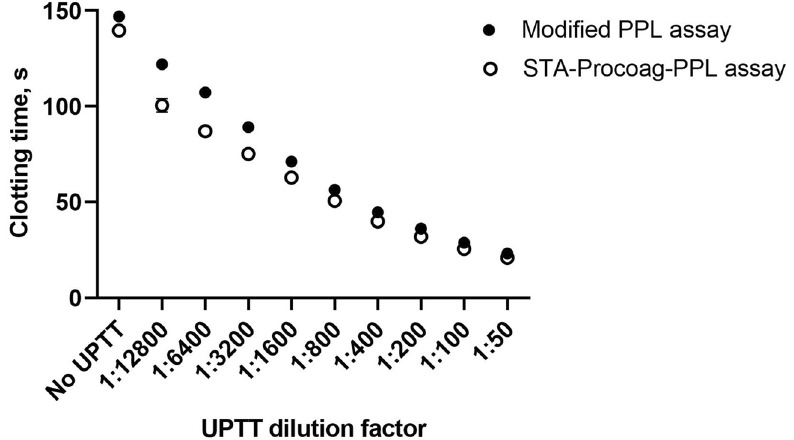
Figure 2. Comparison of the clotting times obtained by the STA-Procoag-PPL and the modified PPL assays using a standardized phospholipid reagent (UPTT reagent). Serial dilutions of UPTT (from 1/50 to 1/12,800), was added to PPL depleted plasma and tested on the modified PPL assay (closed circles) and the STA- Procoag- PPL assay (empty circles). Values are means of three experiments ± 1 SD.